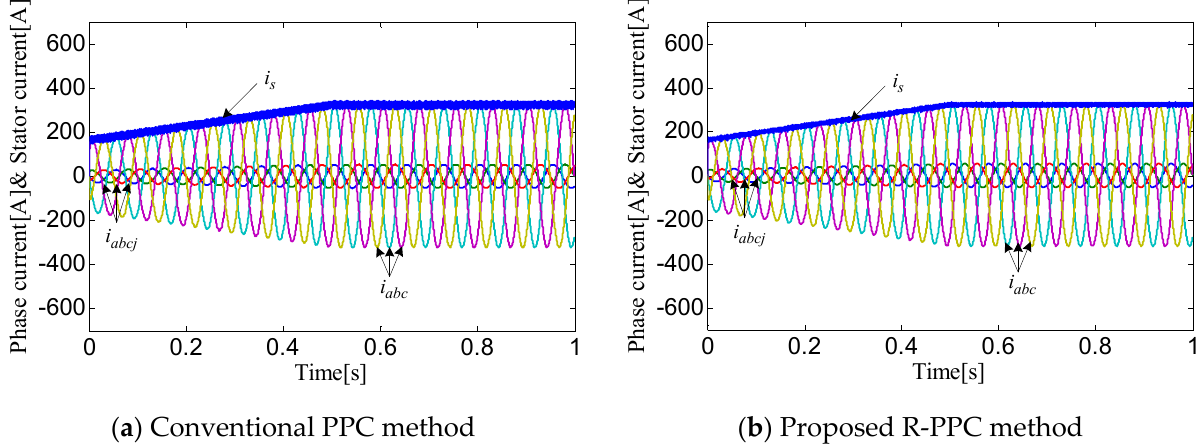
Figure 8. Simulation results of the phase current under the charge state. ( a ) Conventional PPC method; ( b ) Proposed R-PPC method.